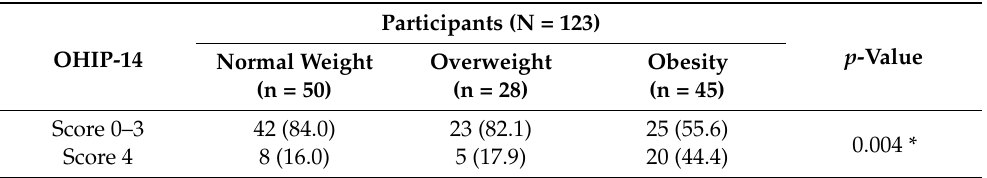
Table 3. Prevalence of participants (n (%)) who scored four for at least one item on the oral health impact profile (OHIP-14). * Significance level at p < 0.05 ( λ 2